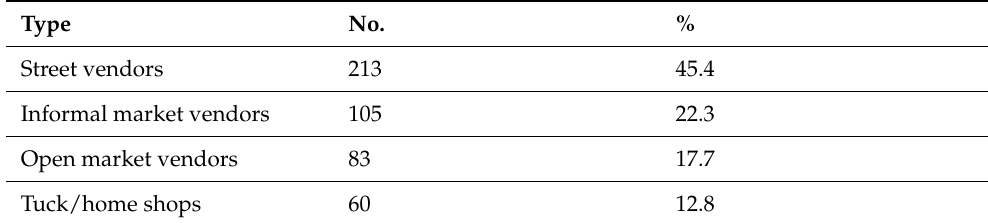
Table 4. Typology of informal food